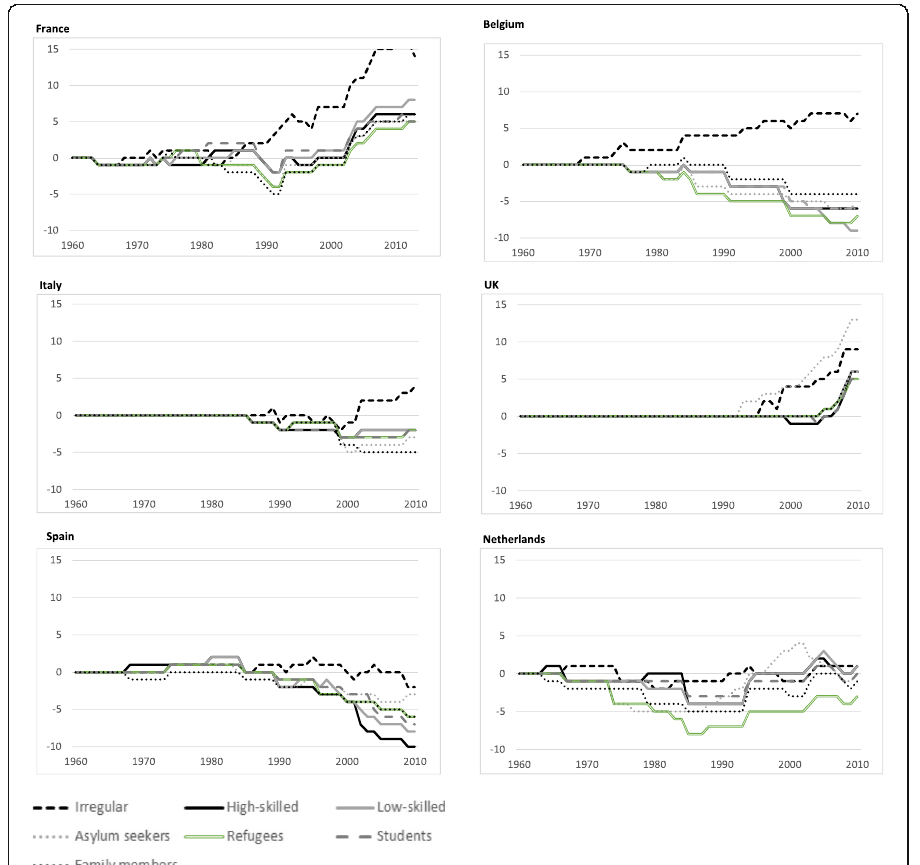
Fig. 4 Integration of non-European migrants: migration policy changes in Belgium, UK, France, Italy, Spain, and The Netherlands, 1960 – 2010. Note: Positive values on vertical axis = more restrictive. Negative values on vertical axis = less restrictive. Source: DEMIG POLICY database recoded by the